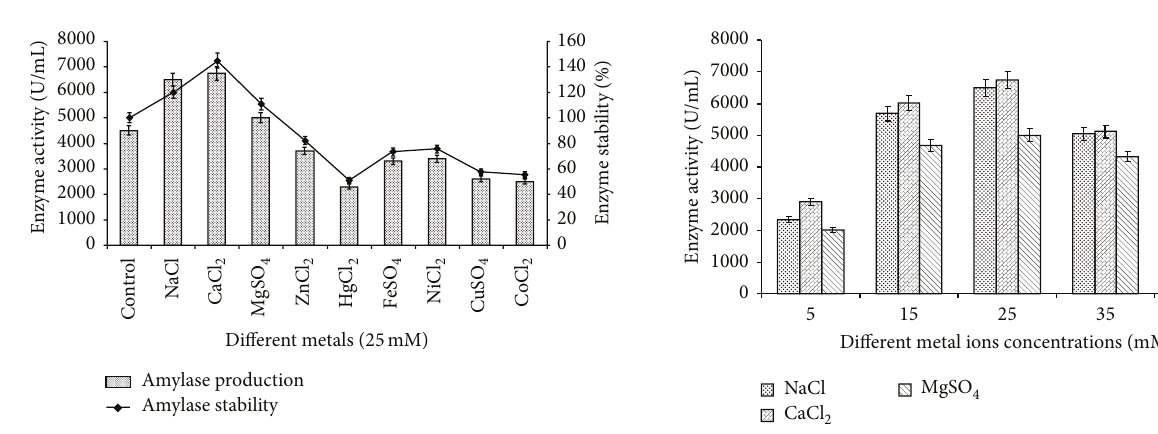
Figure 10: Effect of different metal ions on amylase production and stability.Thecontrolflaskdoesnotcontainanymetalions.Testflasks contained different metal ions in the medium at a level of 25 mM. The flasks were inoculated with culture and were incubated at initial pH 7.0, 55 ∘ C for 24h. For enzyme activity, the reaction was assayed and for stability enzyme was preincubated with different metal ions (25 mM) at 55 ∘ C for 1h and assayed by standard assay method. Error bars presented mean values of ± standard deviation of triplicates of three independent experiments.